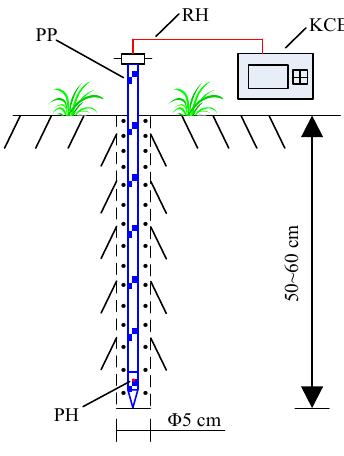
Figure 10. Sizes of the